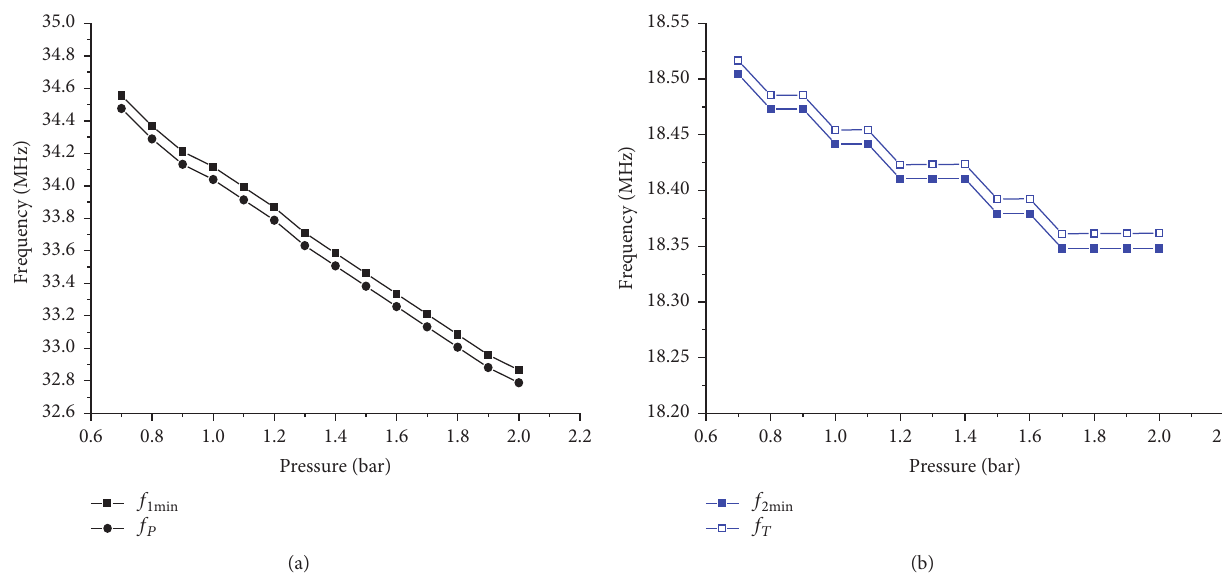
Figure 14: 𝑘 12 = 0.057 decoupling results compared with the experimental data.